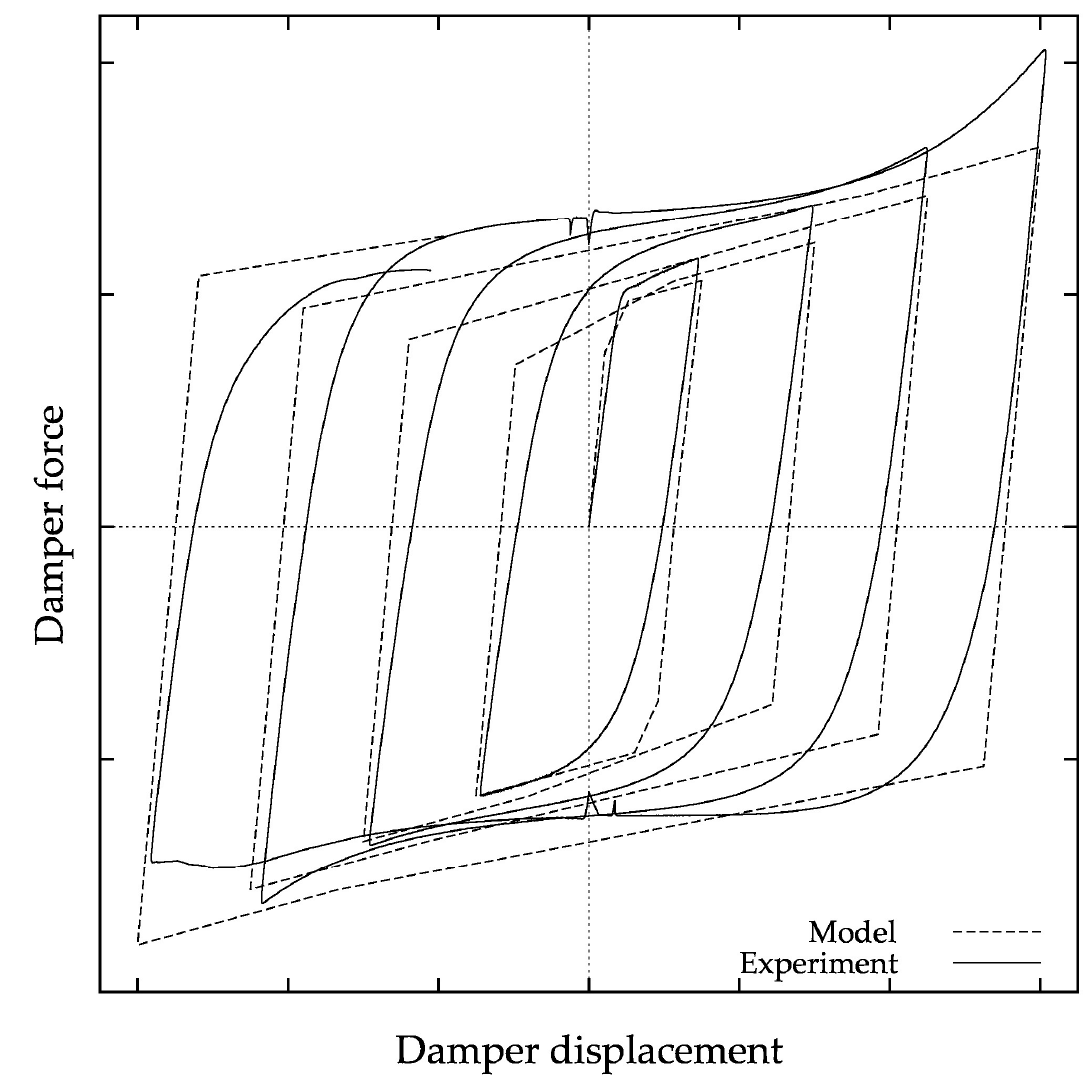
Figure A4. Example of the hysteretic model of dampers.